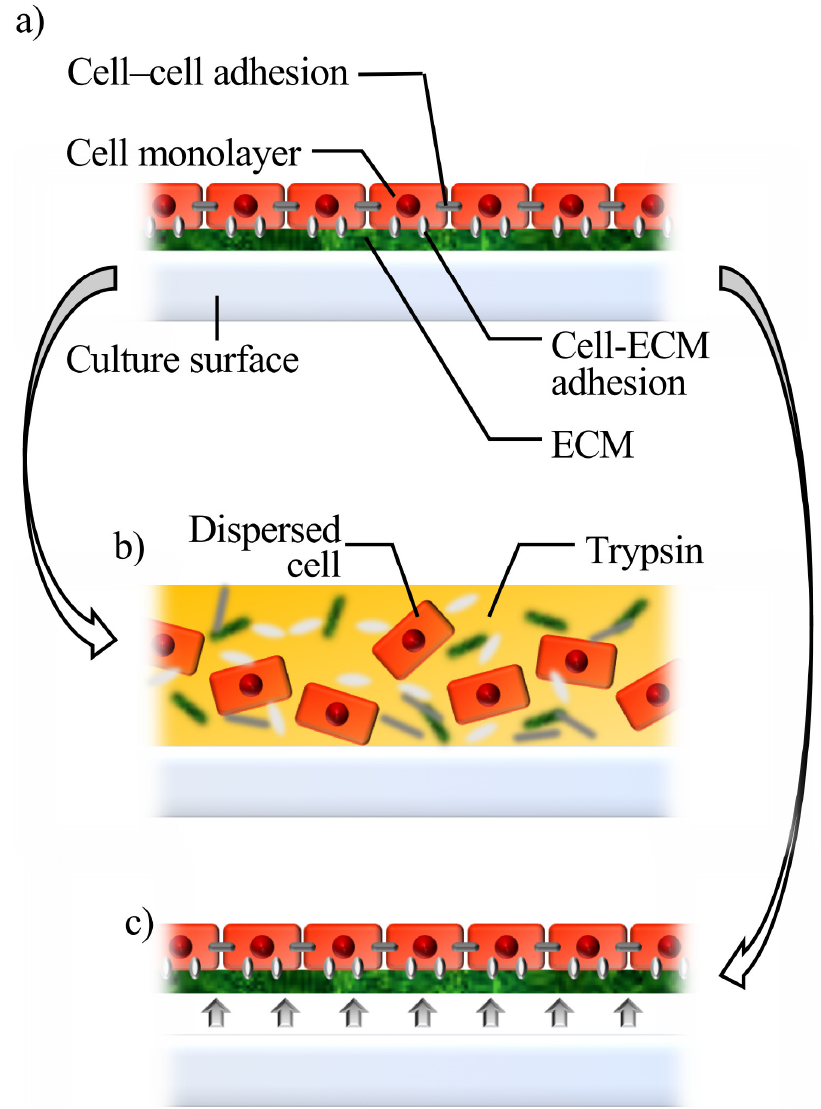
Figure 2. Schematic diagram of cell sheet fabrication. ( a ) Confluent cells on a culture surface. ( b ) Trypsin digests extracellular matrix (ECM) and other surface proteins. Thus, cells become dispersed and lose proteins that are essential for maintaining cell functions. ( c ) When adhesions between the cell-culture surface are selectively lost, confluent cells can be detached in the shape of a sheet.